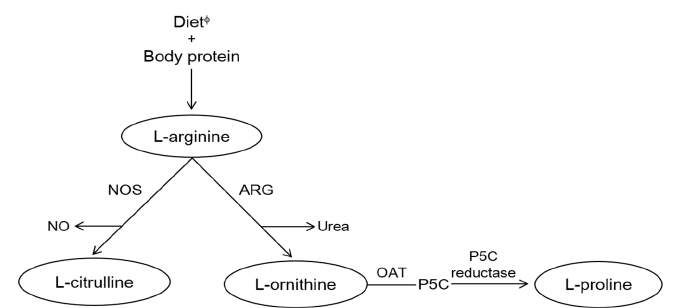
Figure 1. Arginine metabolism. ARG, arginase; NO, nitric oxide; NOS, nitric oxide synthase; OAT, ornithine aminotransferase; P5C, L -pyrroline-5-carboxylate. φ Major dietary sources of L -arginine are meat, poultry, fish, dairy products, nuts, etc.